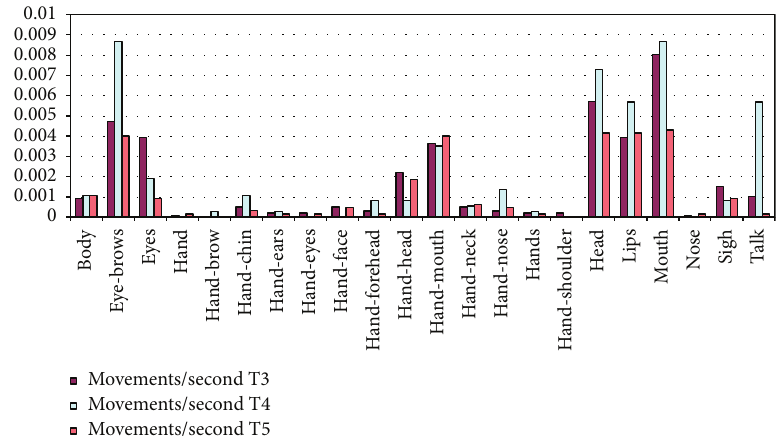
Figure 5: Mean of scores of specific facial and body movements showed by each participants along the three tasks